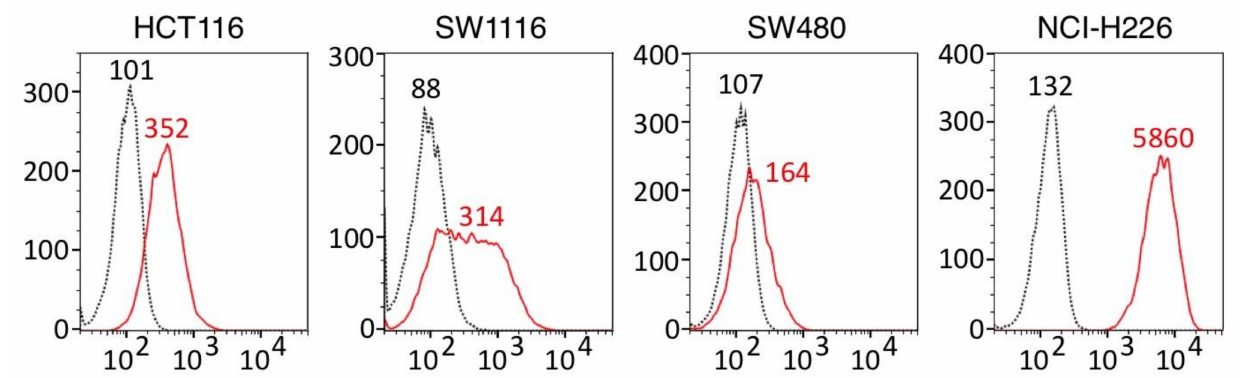
Figure 1. Cell surface ERC/mesothelin expression on human colorectal adenocarcinoma cells. Membranous ERC/mesothelin expression was measured by flow cytometry in human colorectal adenocarcinoma cell lines (HCT116, SW1116 and SW480). Cells reacting with anti-ERC/Mesothelin (22A31) or mouse IgG1 κ (isotype-matched control) are indicated by red solid lines or black dashed lines, respectively. H226, NCI-H226 human mesothelioma cell used as a positive control. Median fluorescence intensity of 22A31- or IgG1 κ -treated cells are shown in red or black letters respectively in each histogram.